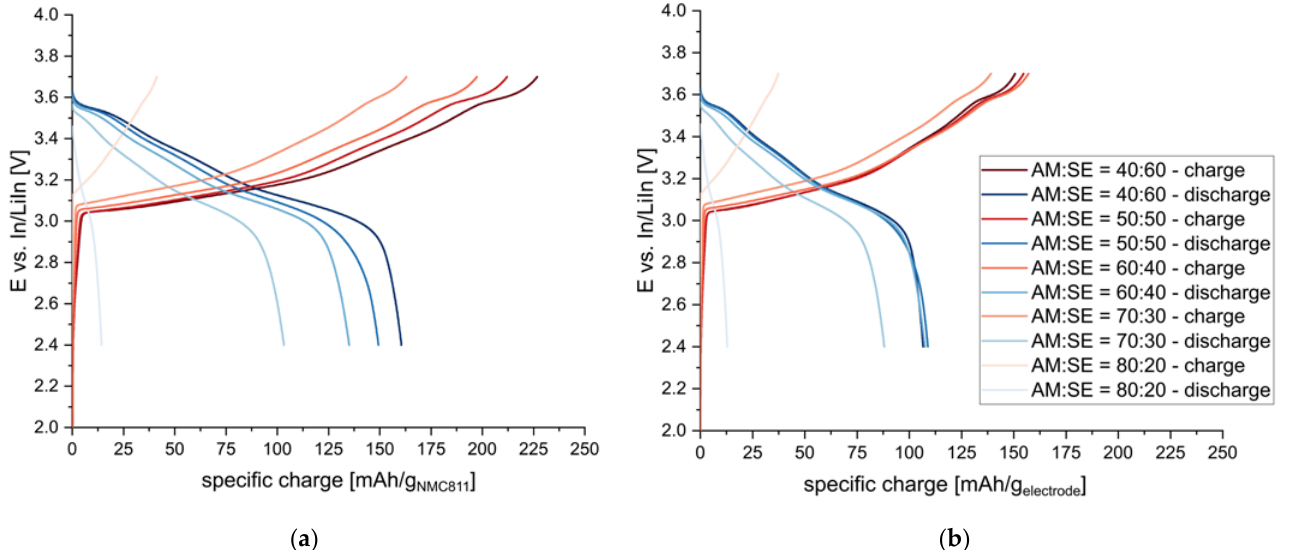
Figure 6. Potential profiles of composite cathodes using different AM:SE ratios (vol./vol.): ( a ) Specific charge values are given with respect to the active material and ( b ) with respect to the electrode material (AM+SE+CA).